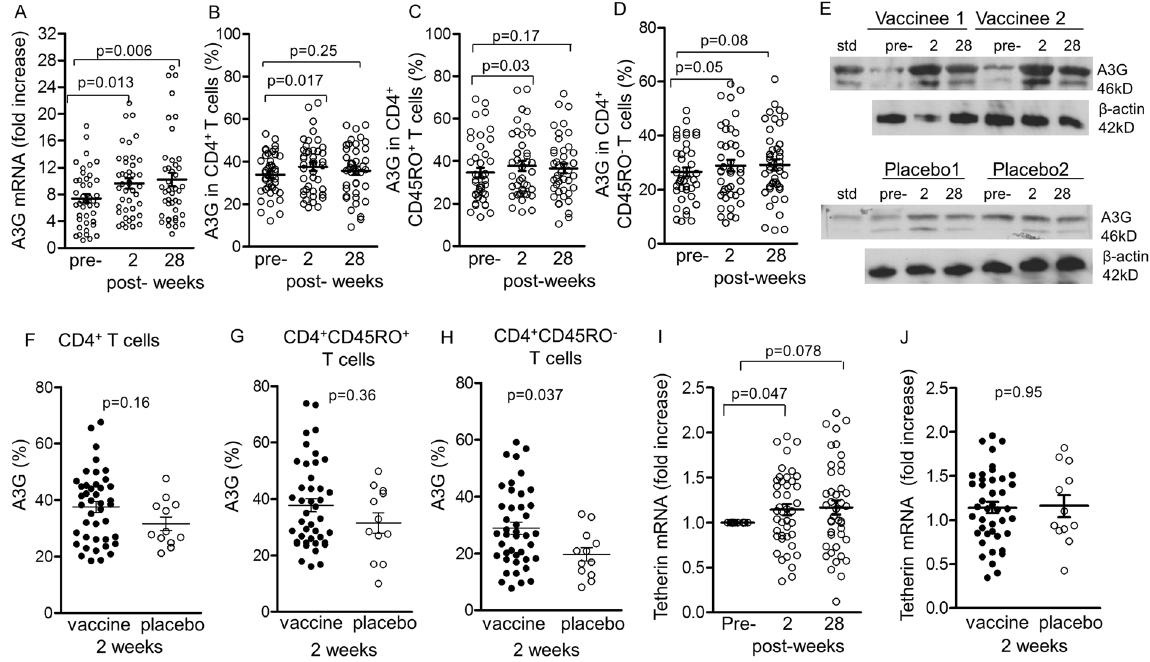
Figure 6. The restriction factors A3G and Tetherin 2 and 28 weeks after immunization. ( A ) A3G mRNA expression in PBMC examined by RT-PCR, ( B ) intracellular A3G in CD4 + T cells, ( C ) CD4 + CD45RO + memory and ( D ) CD4 + CD45RO − naïve T cells were all studied by flow cytometry. ( E ) Western blots of PBMC lysates from 2 representative vaccines and 2 placebo controls; the blots were trimmed above about 50 kD and below 40 kD. ( F ) A3G in vaccinees was compared with the placebo groups at 2 weeks in CD4 + ( G ), CD45RO + ( H ) CD45RO − T cells. ( I ) Tetherin mRNA was tested in PBMC before, 2 and 28 weeks after completion of immunization and ( J ) in vaccinees compared with placebos. Immunized (n = 42) placebo (n = 12, all from different subjects).